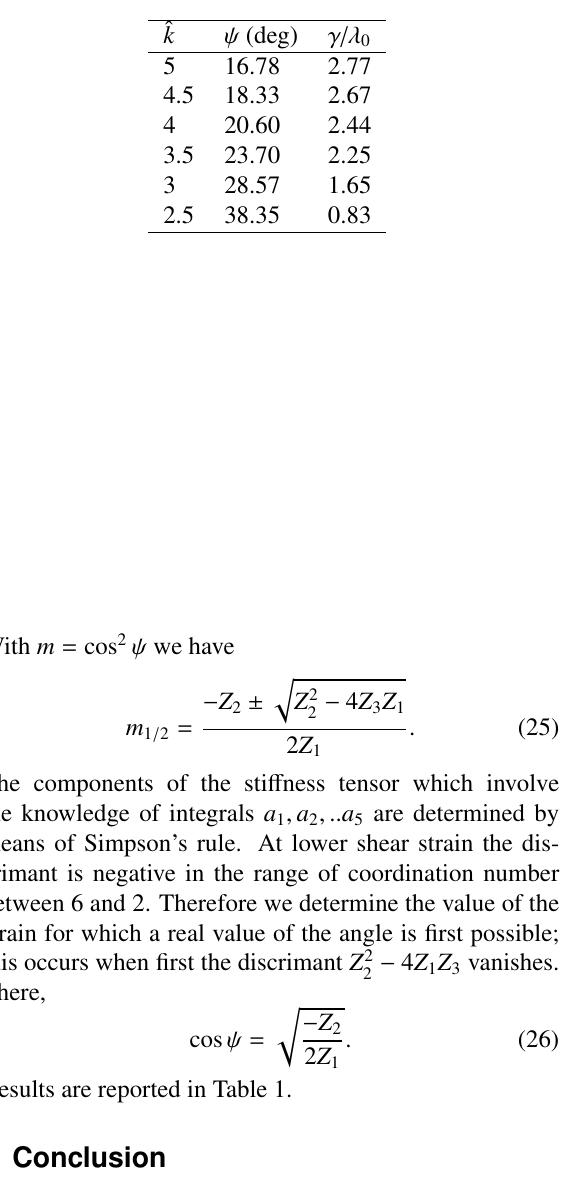
Table 1. Localization angle at given coordination number and normalized shear